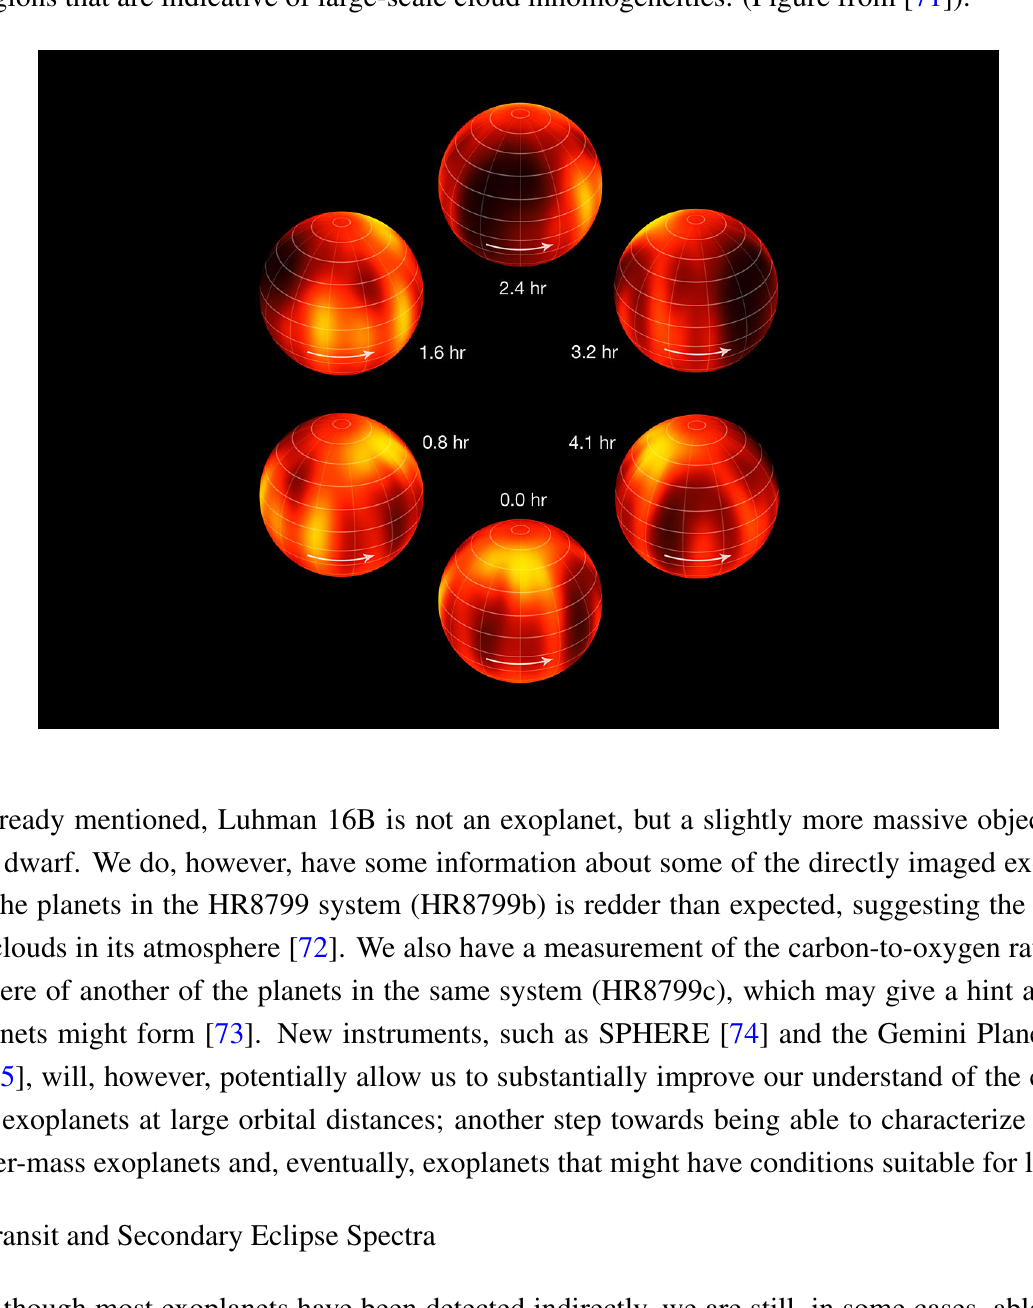
Figure 10. Surface maps of the brown dwarf, Luhman 16B, showing darker and brighter regions that are indicative of large-scale cloud inhomogeneities. (Figure from